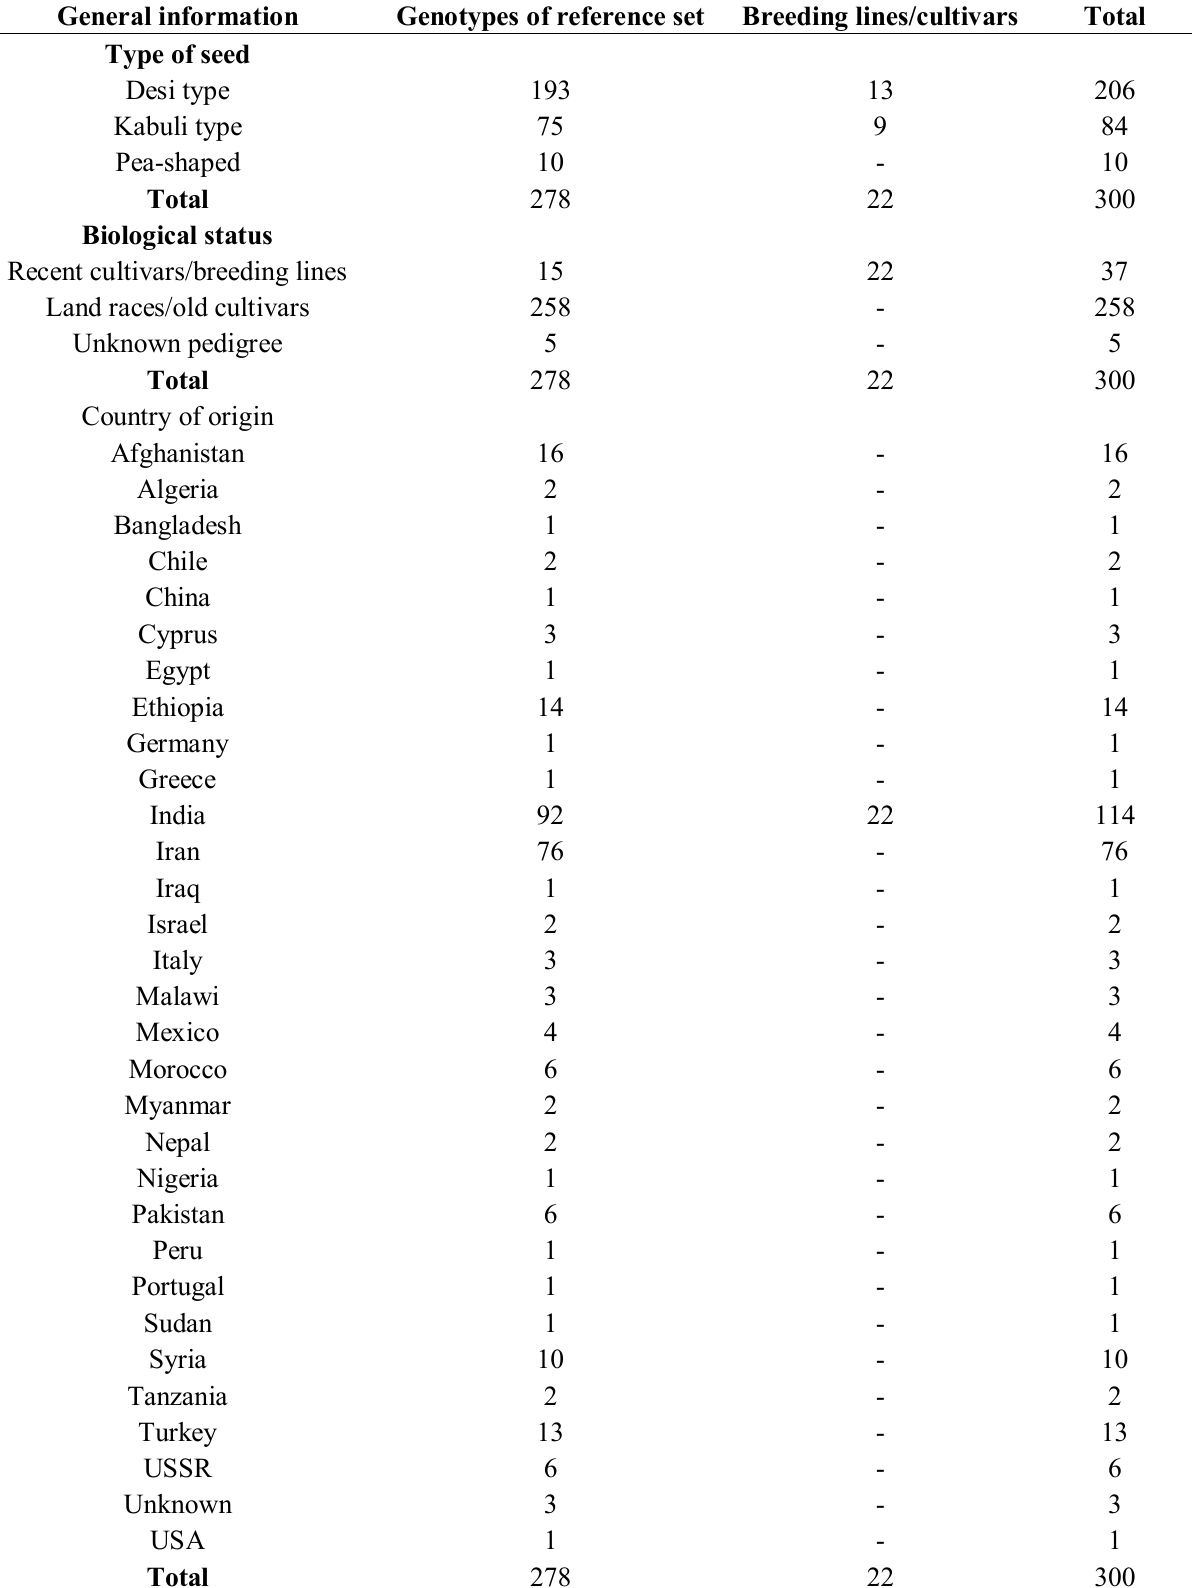
Table 3. General information on chickpea genotypes used for herbicide tolerance screening. General information Genotypes of reference set Breeding lines/cultivars Total Type of seed Desi type